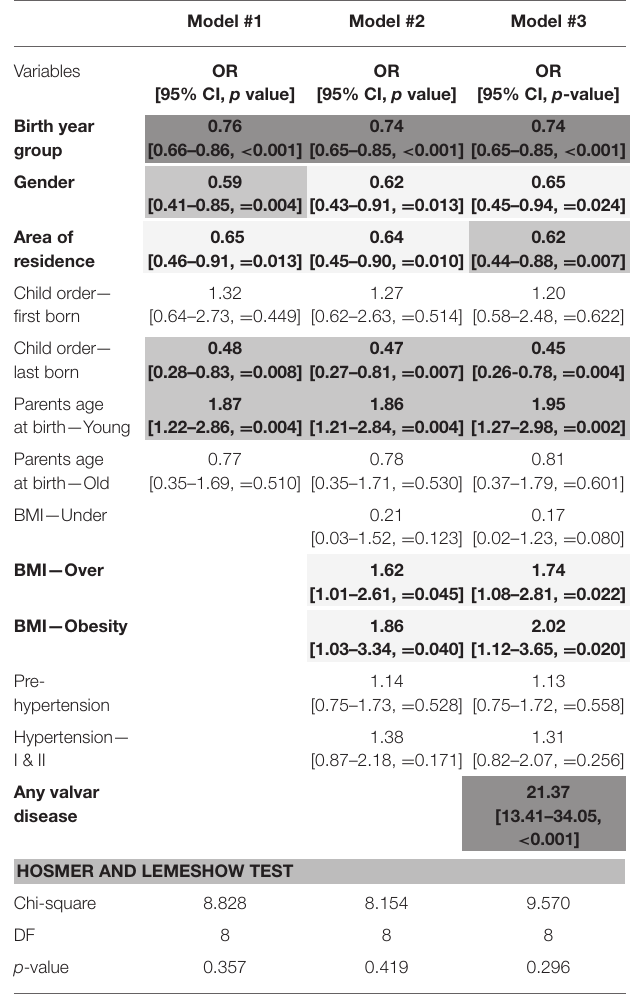
TABLE 1 | Multivariable logistic regression analyses of Acute rheumatic fever (ARF as outcome) and diverse socio-demographic variables, anthropometric indices and valvar